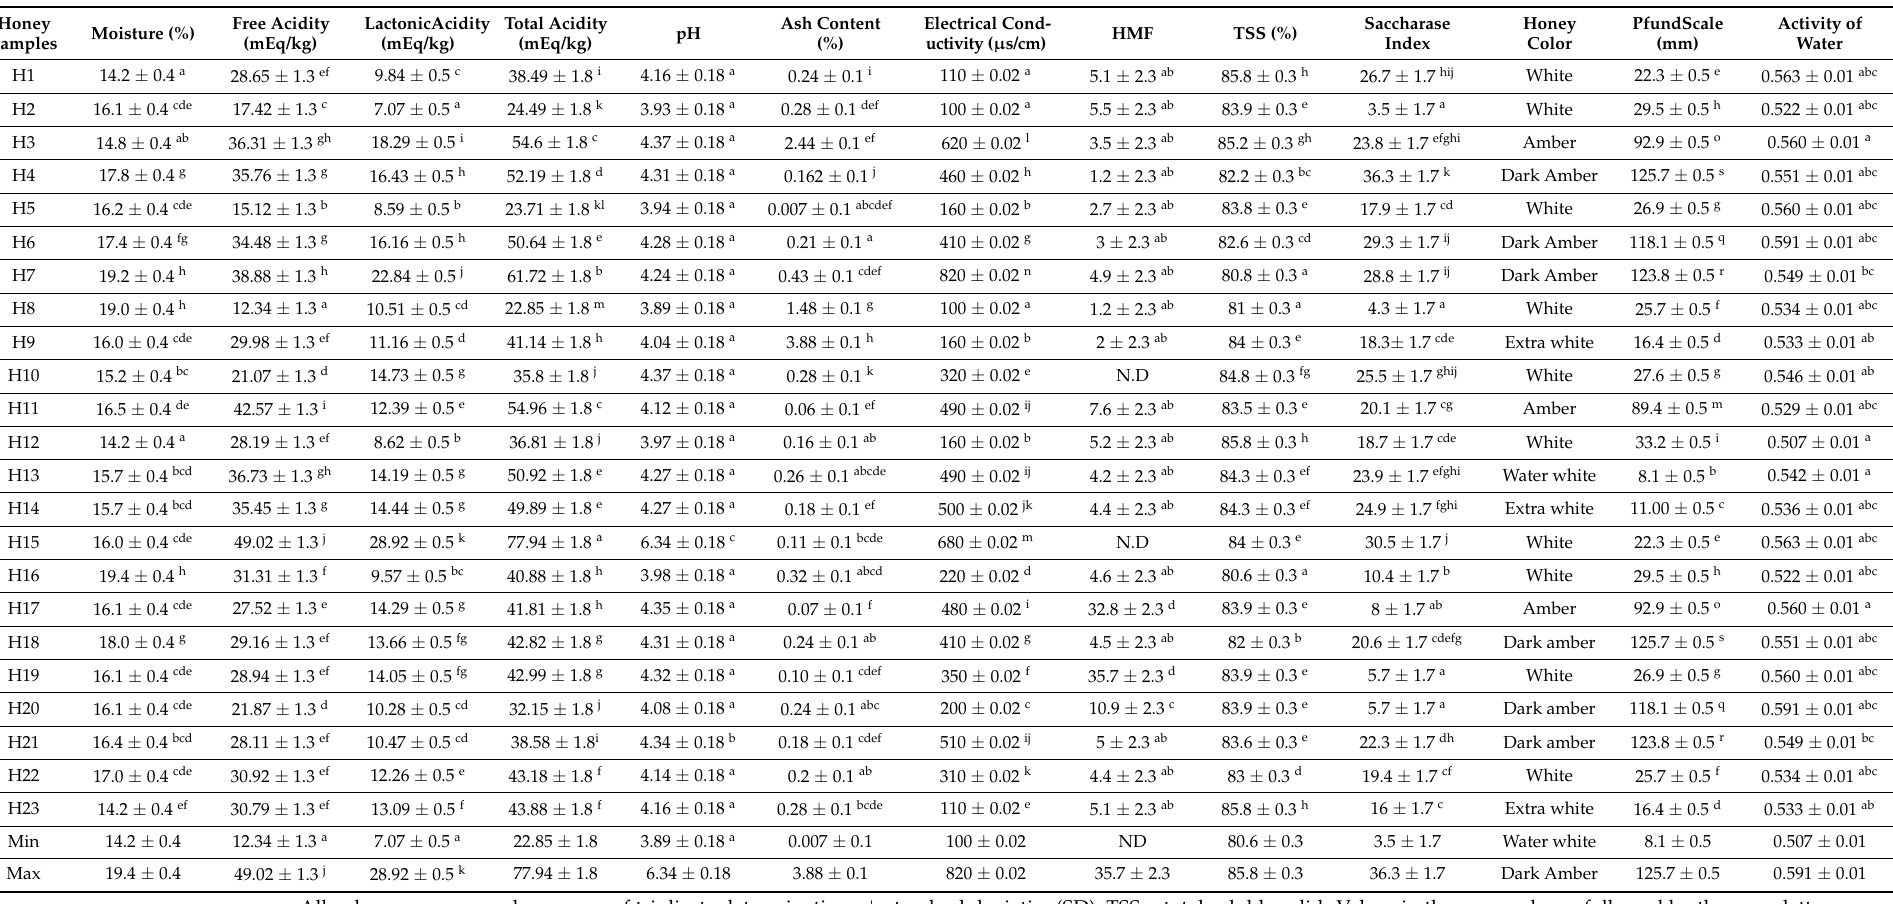
Table 3. Physicochemical analysis of honey